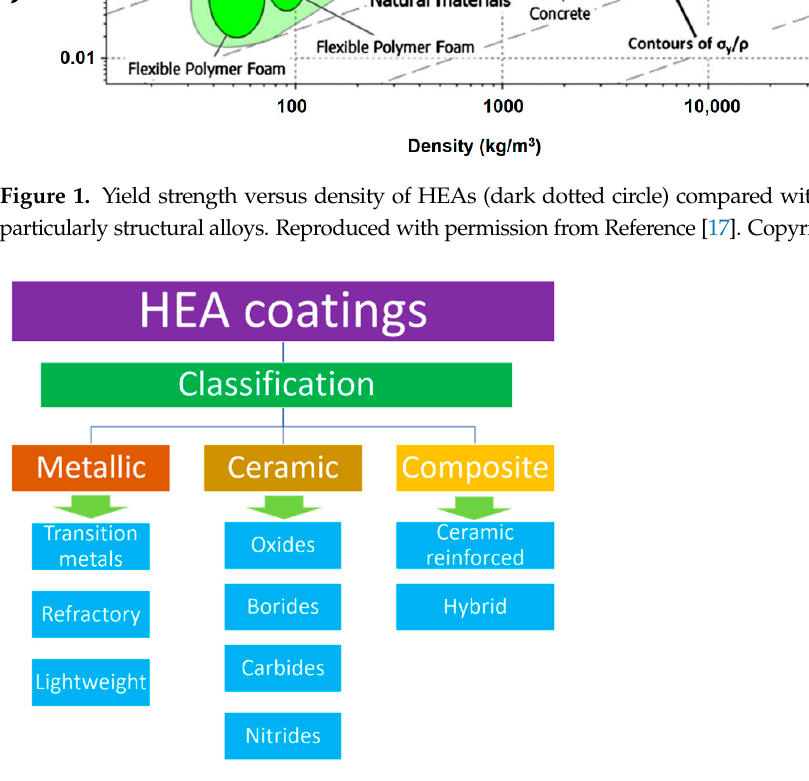
Figure 1. Yield strength versus density of HEAs (dark dotted circle) compared with other materi- als, particularly structural alloys. Reproduced with permission from Reference [17]. Copyright 2014 Elsevier.